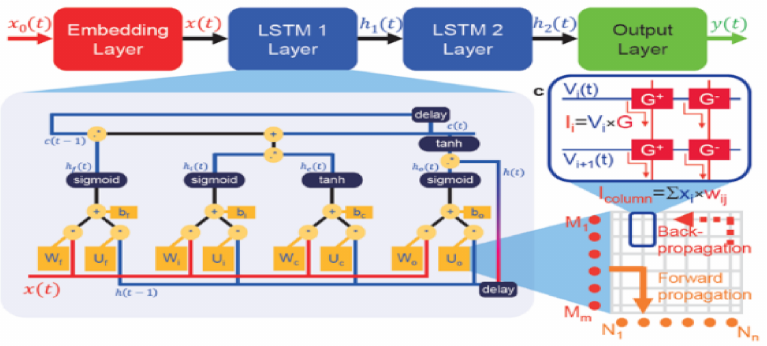
Figure 19. Realization method of long short-term memory network based on phase-change memory device unit.